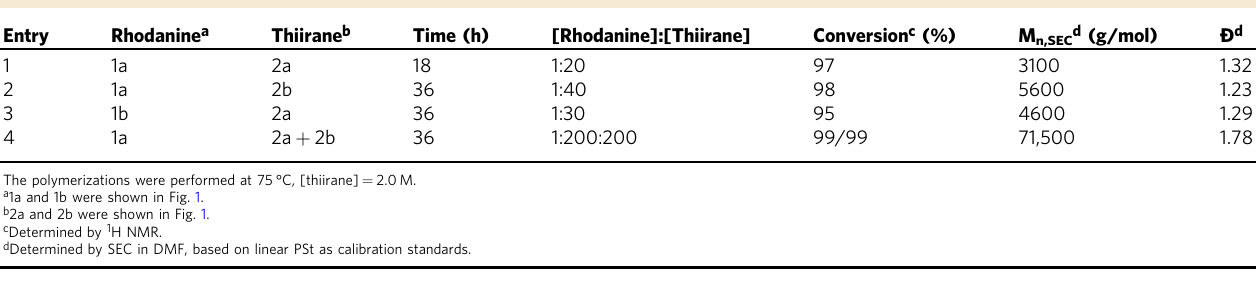
Table 1 The results of AROP using rhodanine and its derivative as the